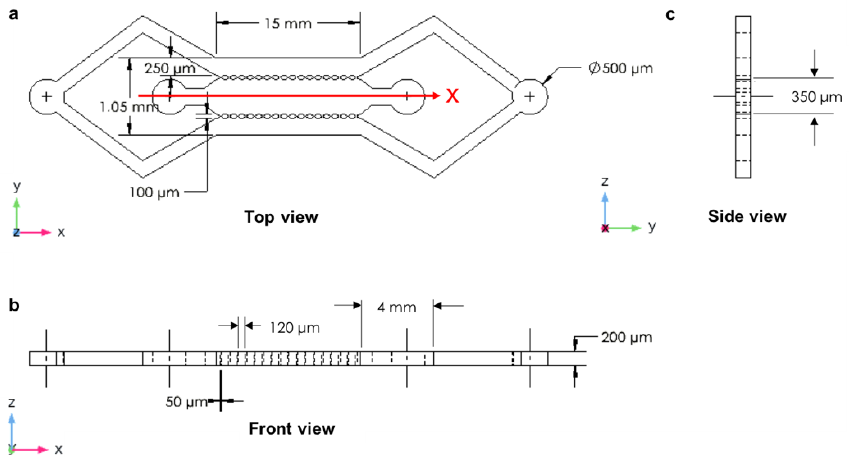
Figure 4. The closed microchannel structure: ( a ) top view with high micropillar magnification; ( b ) front view; ( c ) side view.